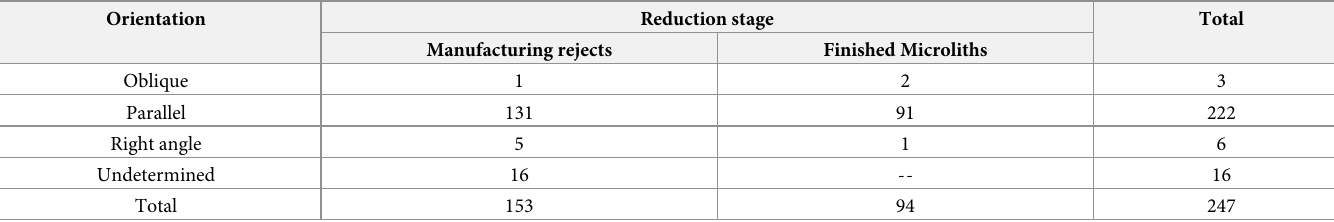
Table 6. Backed microlith orientation relative to percussion axis, Horizon IV, Saruq al-Hadid. Orientation Reduction stage Total Manufacturing rejects Finished Microliths Oblique 1 2 Parallel 131 91 222 Right angle 5 Undetermined 16 -- Total 153